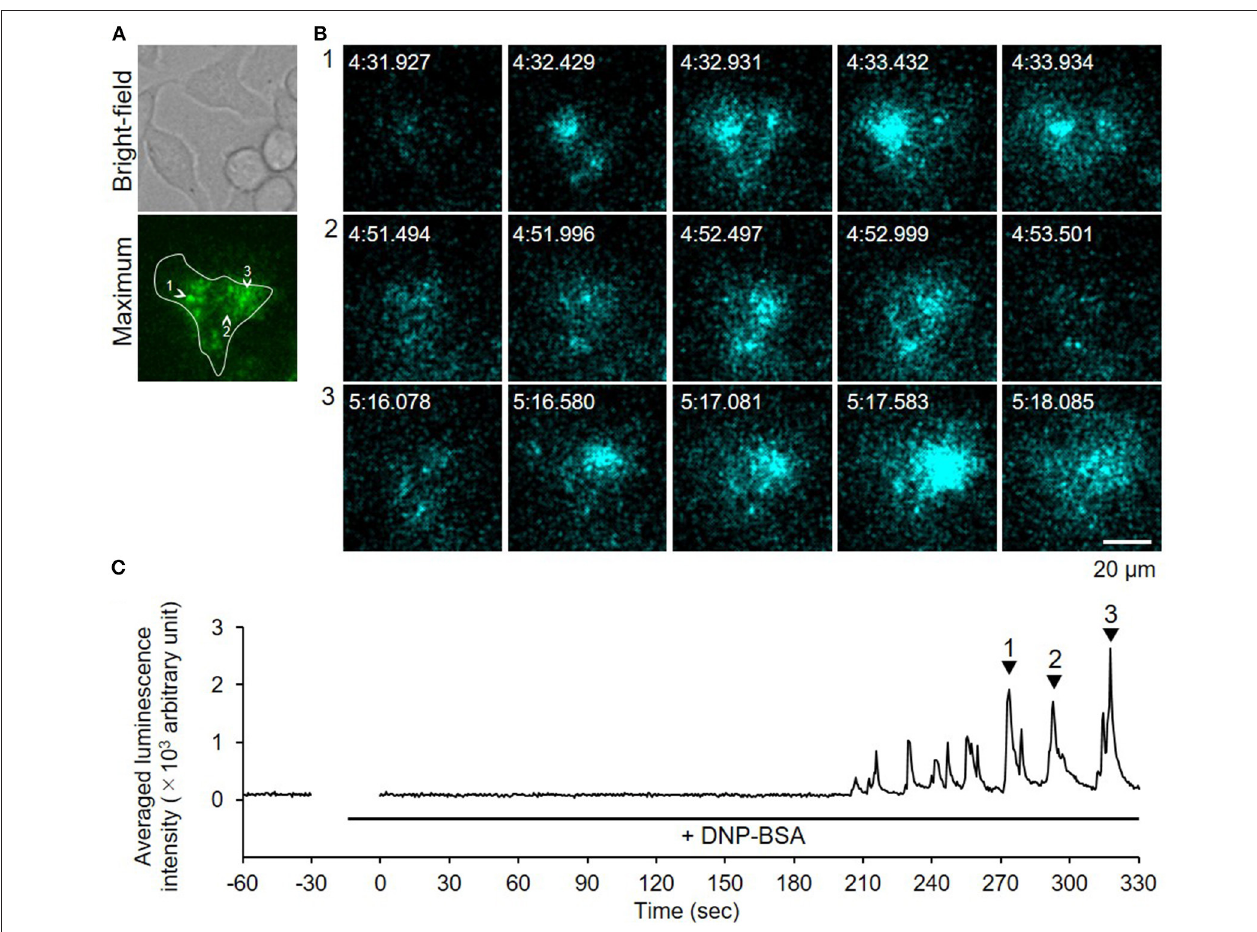
FIGURE 5 | Video-rate bioluminescence microscopy of NPY-GLase secretion from RBL-NPY-GLase cells attached to extracellular matrix ECM gel. (A) A bright-field and luminescence images of RBL-NPY-GLase cells. The focal plane was adjusted to 2 µ m from the bottom side of the cells on the Matrigel-coated glass plate. A “maximum” image shows the maximum luminescence intensity obtained from all frames in the video image after stimulation with DNP-BSA. (B) Successive luminescence images of secreted NPY-GLase for a few seconds. Each sequential image (1–3) corresponds to the respective numbers with arrowheads in C . (C) Time-dependent changes of luminescence intensities of secreted NPY-GLase in the indicated areas corresponding to the single cell in the “maximum”